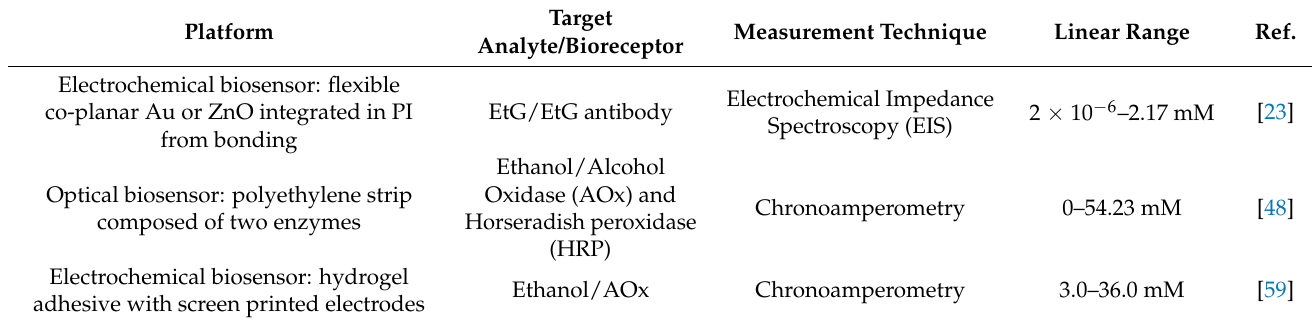
Table 2. Flexible biosensors to detect alcohol in sweat.